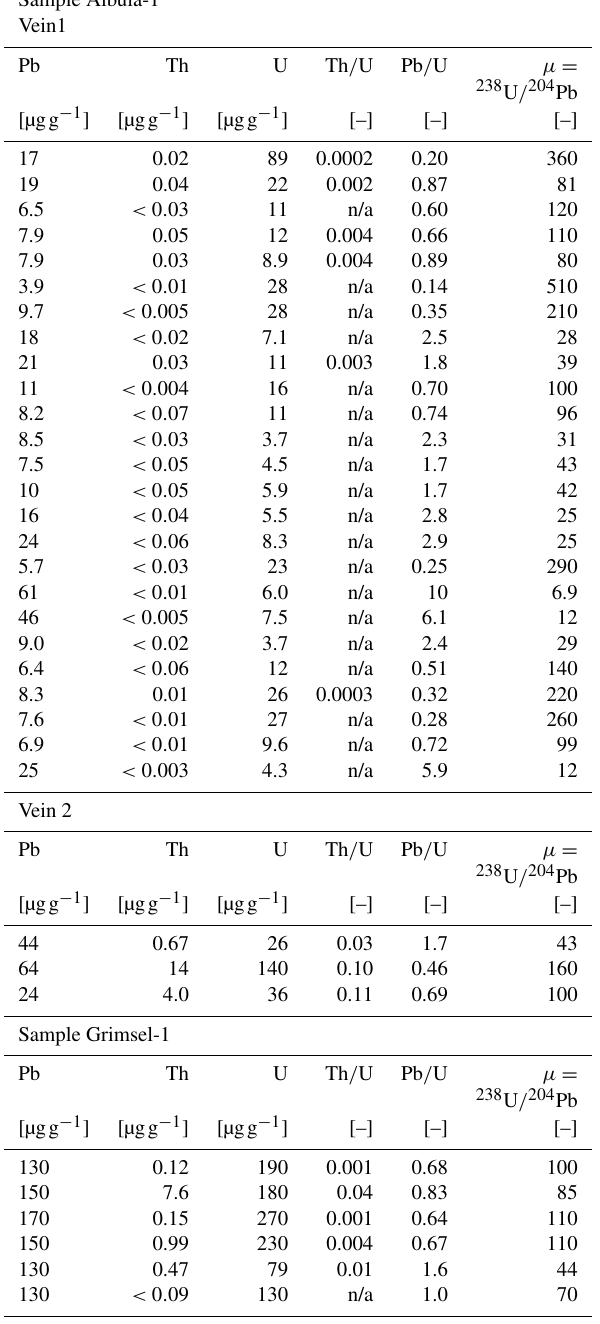
Table 4. Concentrations of Pb, Th, and U, as well as the Th / U and Pb / U ratios and µ values measured by laser ablation ICP-MS with the trace element protocol in Appendix A. The symbol < is fol- lowed by limits of detection (calculated for each element in each measurement individually following the formulation in Pettke et al., 2012). µ values are calculated from total Pb and total U con- tents by considering an isotopic abundance of 1.4% for 204 Pb and 93% for 238